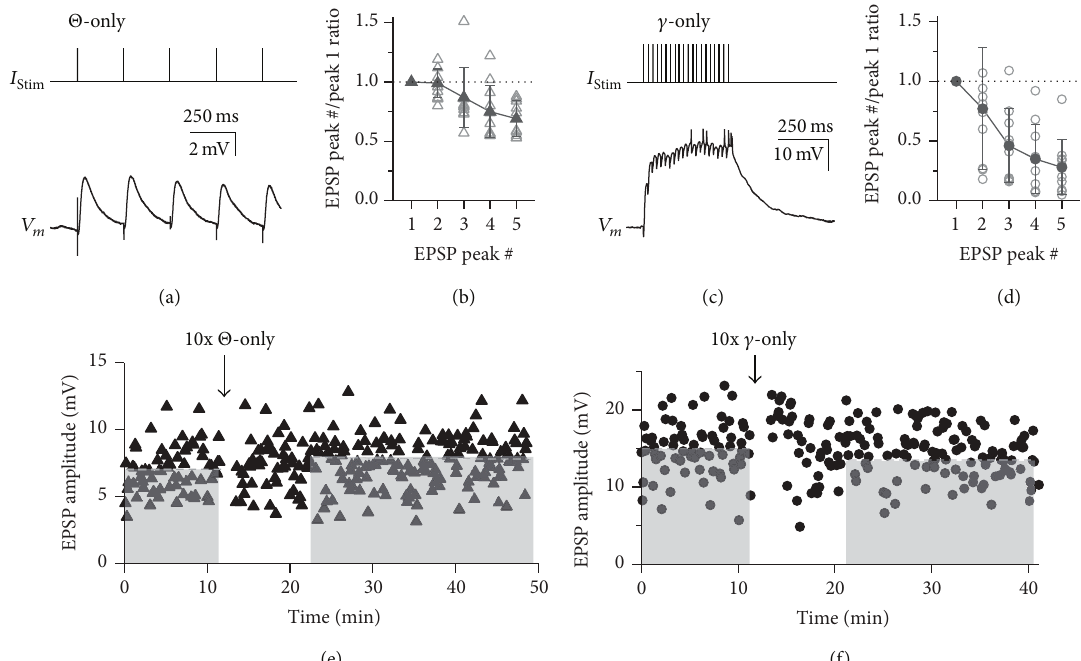
Figure 2: Short- and long-term plasticity in response to Θ -only and 𝛾 -only stimulation. (a) Representative example of response to Θ -only protocol averaged over the total of 10 stimulations. (b) Cumulative data of EPSP amplitude ratios relative to first peak in train ( 𝑛 = 10 cells). Open symbols: individual experiments. Solid symbols: averaged data. (c) Same as in (a) but for 𝛾 -only protocol. (d) Same as in (b) but for 𝛾 -only protocol. Cumulative data of EPSP amplitude ratios relative to first peak in train ( 𝑛 = 10 cells). (e, f) EPSP amplitudes of individual long-term experiments with induction responses shown in (a) and (c), respectively. Cumulative data for both Θ -only and 𝛾 -only data sets are shown in Figure 4(a). (e) Θ -only. Control mean 7.5 mV; long-term mean 8.1mV (dashed lines). (f) 𝛾 -only. Control mean 15.1 mV; long-term mean 13.0 mV (dashed